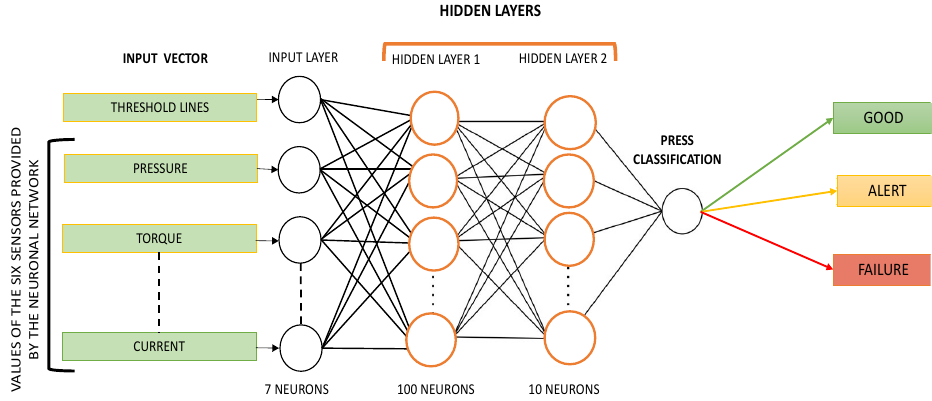
Figure 12. Architecture of the ANN for classification of the state of the paper press.